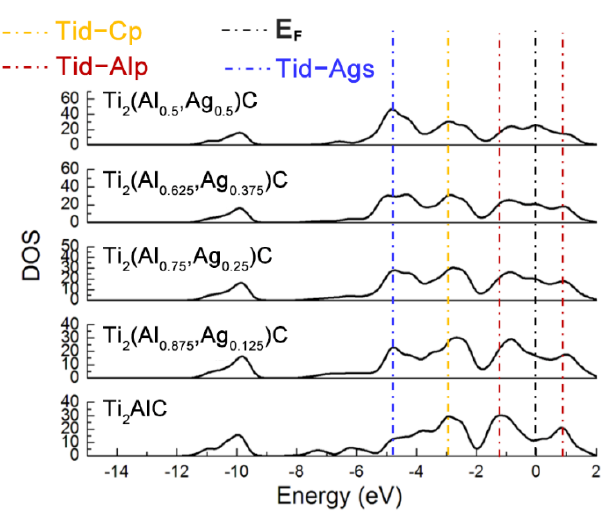
Figure 3. TDOS of the Ti 2 (Al 1 − x ,Ag x )C supercells with different substitution ratios of Ag for Al.